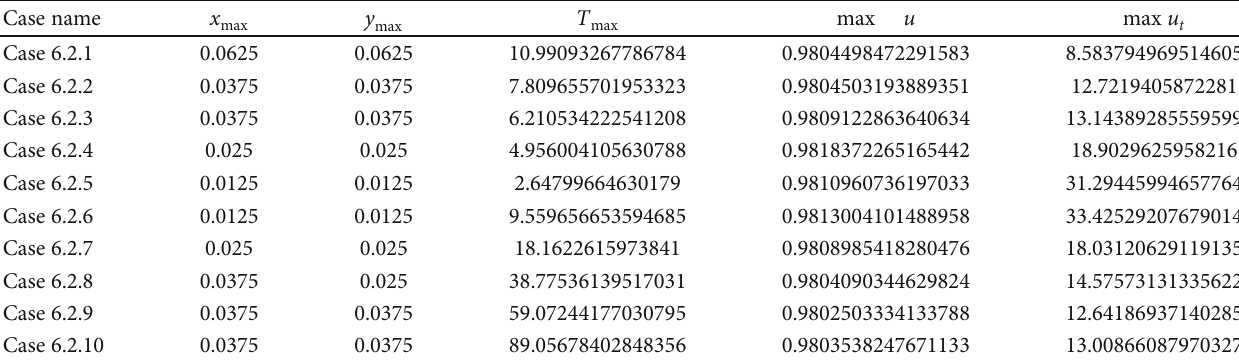
b x and y based on convection term